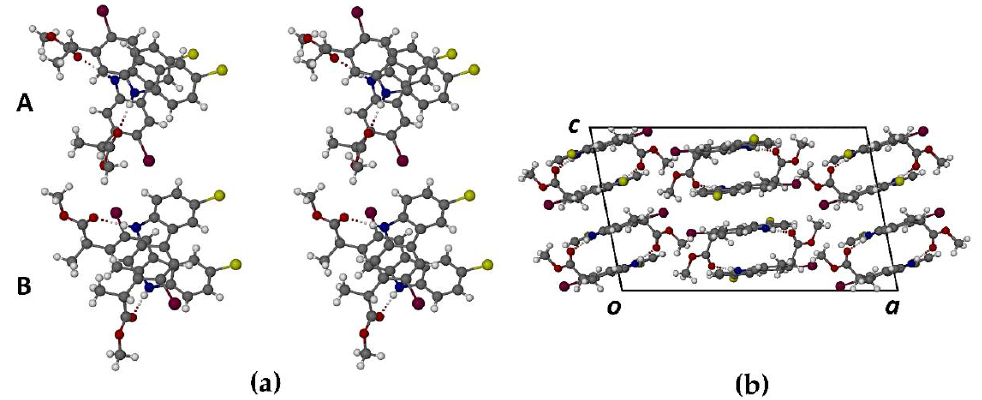
Figure 6. Stereoscopic view of the repeating supramolecular motif in the crystal of 5 propagating parallel to the crystal c-axis ( a ), and the crystal packing shown in the [010] projection ( b ). Dotted lines represent hydrogen bonds.